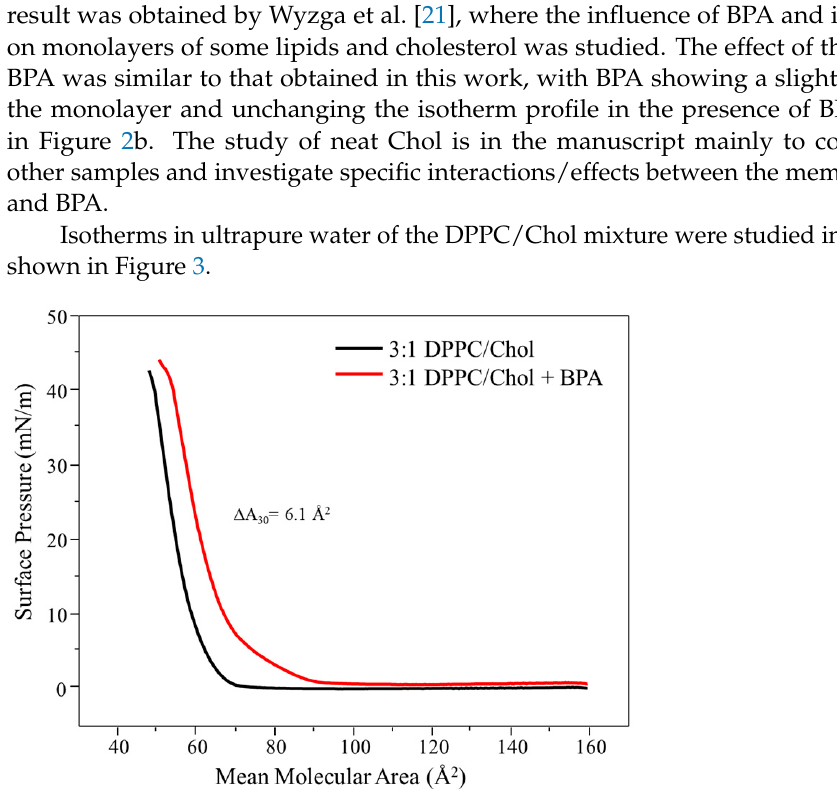
Figure 3. π -A isotherm for the mixture of DPPC and cholesterol (3:1) Langmuir film in ultrapure water subphase and the presence of BPA (1 × 10 − 5 mol/L).